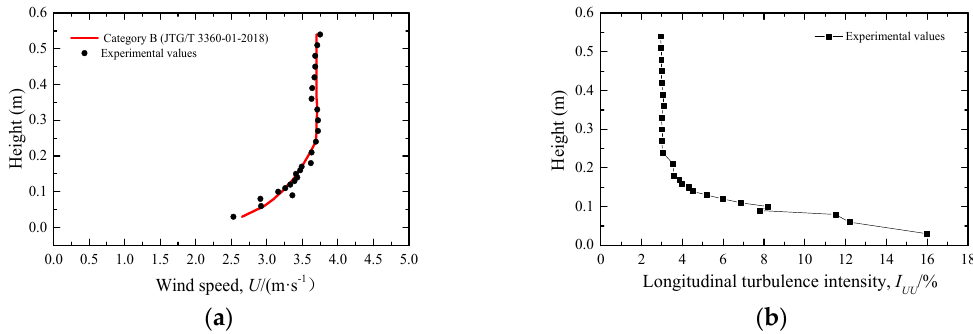
Figure 9. Wind speed and turbulence intensity profiles at different height. ( a ) Wind speed profile; ( b ) Longitudinal turbulence intensity profile.